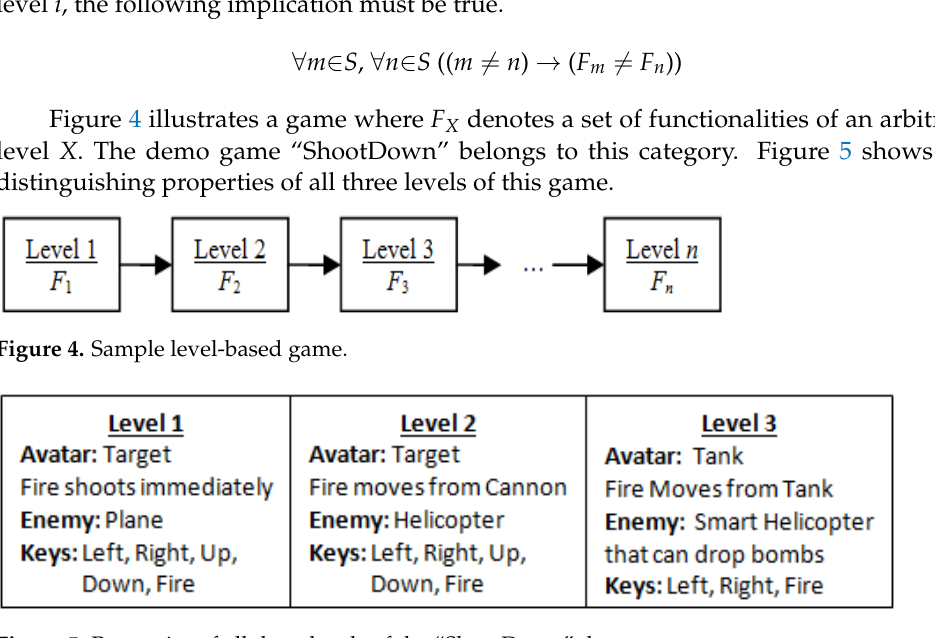
Figure 5. Properties of all three levels of the “ShootDown” demo game.